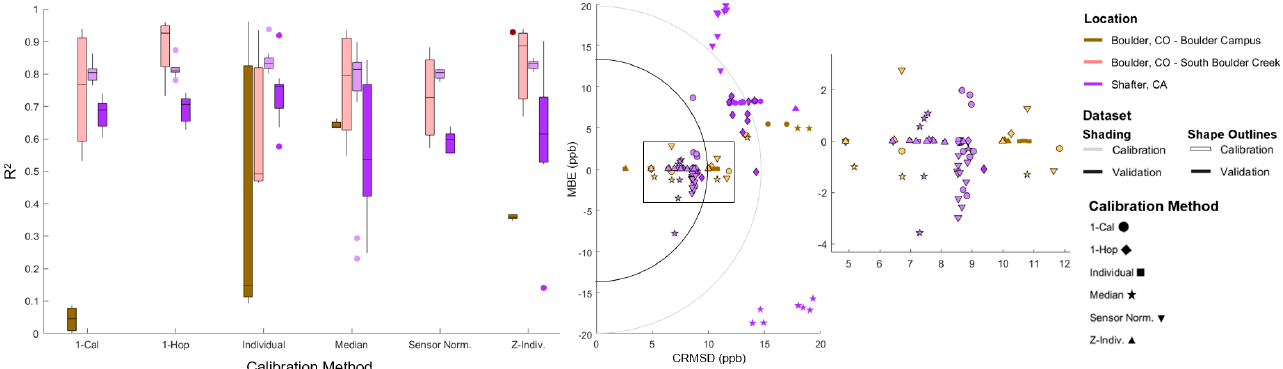
Figure 5. R 2 ( left ) and MBE vs. CRMSD target plot ( right ) for all sensor signal normalization and multi-pod calibration approaches studied for ozone against a reference-grade instrument. The box-and-whiskers are each in the following order from left to right: Boulder validation (Boulder Campus), Boulder calibration (South Boulder Creek), Shafter calibration, Shafter validation.